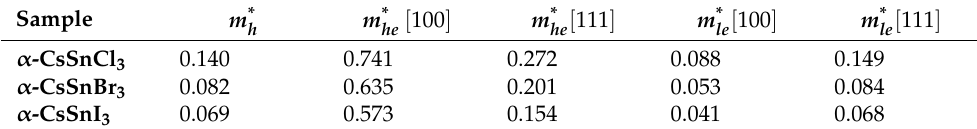
Table 3. Calculated effective mass ( m ∗ ) at the band edges (without spin-orbit coupling). These values correspond to electron mass. Near VBM, the band is nondegenerate, and the dispersion of the band is isotropic and parabolic (h = hole, e = electron, le = light, he = heavy). Reproduced with permission [33]. Copyrisght 2013, APS Physics.